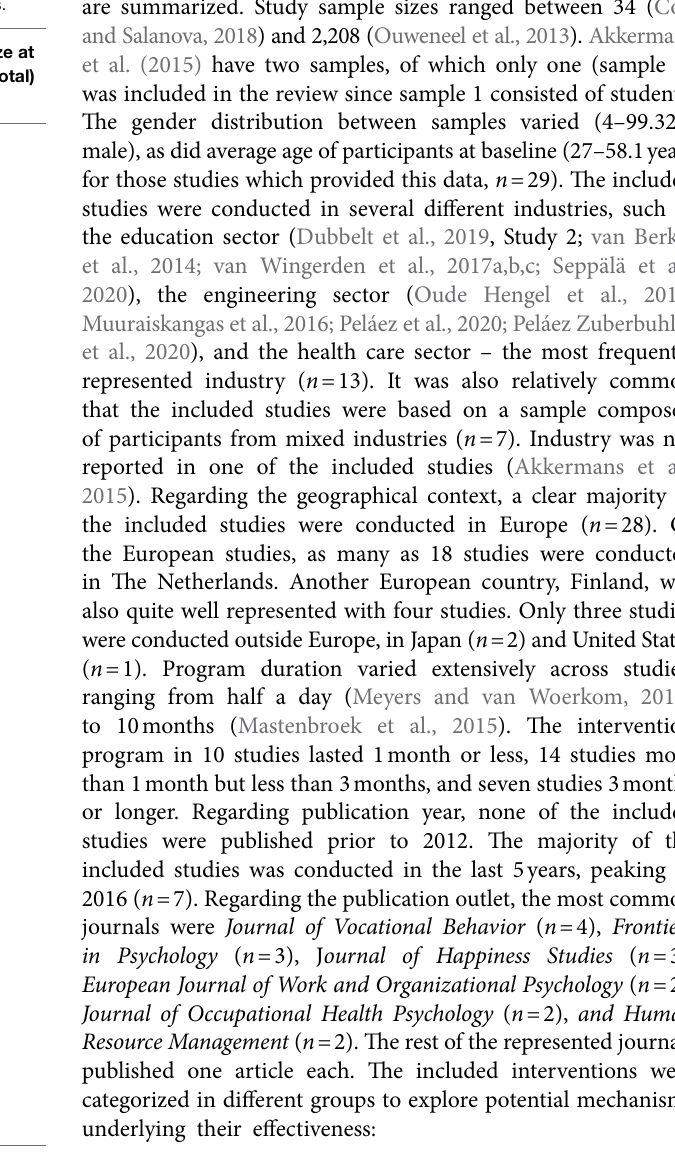
TABLE 2 | Sample size at baseline of studies included in the